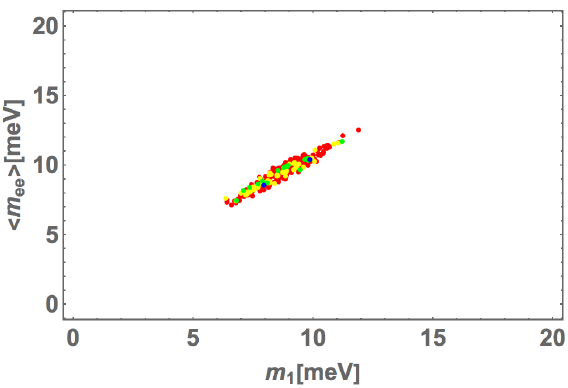
Figure 5 . Allowed region of h m ee i in terms of the lightest neutrino mass m 1 meV, where the color legends are the same as the one in figure 1.